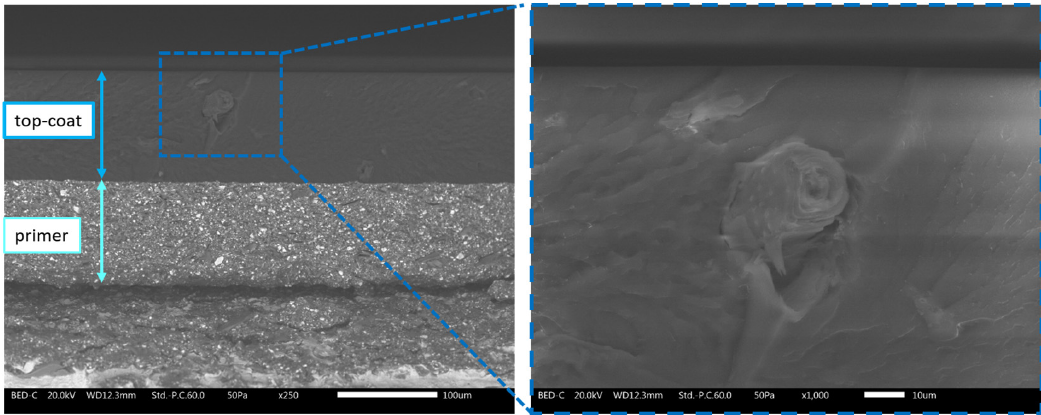
Figure 2. SEM micrograph of the cross-section of coating S, with the enhancement of an olive pit granule embedded inside the top coat.